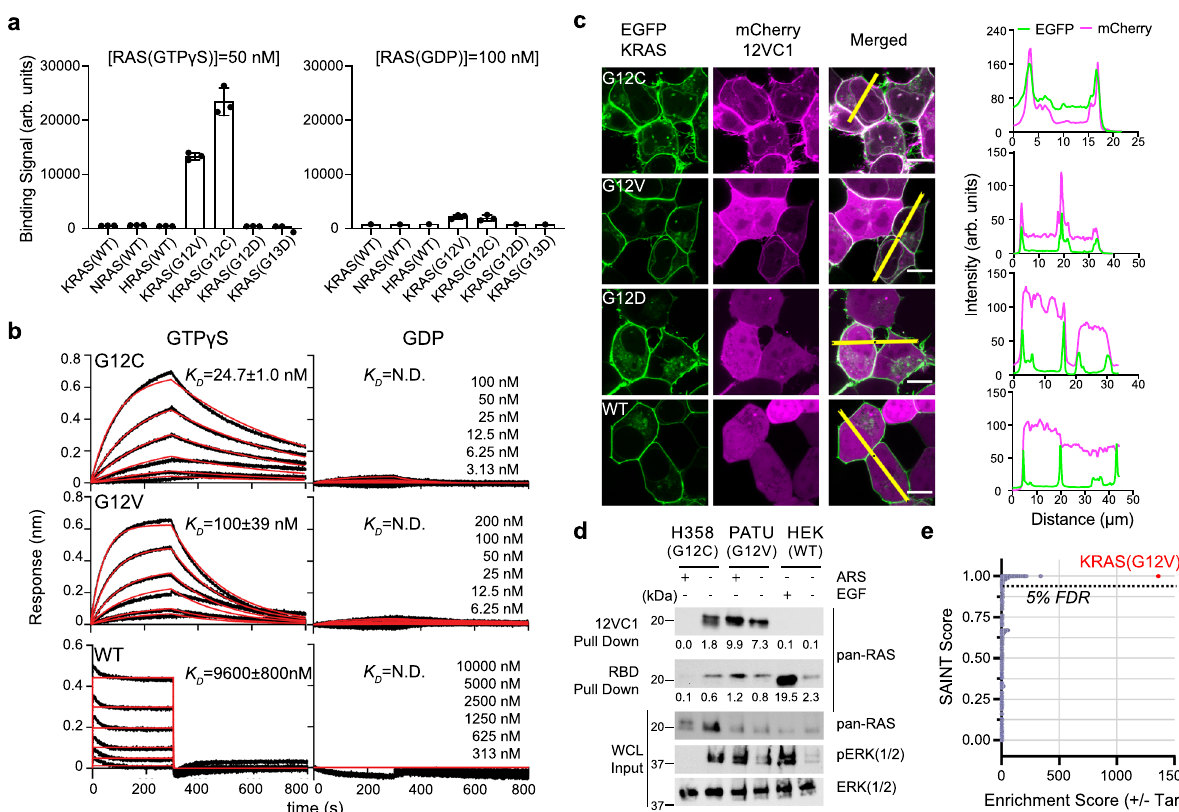
Fig. 1 Monobody 12VC1 is selective to the G12C and G12V RAS mutants. a Yeast display binding measurements of 12VC1 to the wild-type RAS isoforms and KRAS mutants in GTP γ S (50 nM) or GDP (100 nM) bound forms. Each data point represents one technical replicate. Binding of biotinylated RAS was detected with neutravidin-Dylight 650. Binding signals in arbitrary units (arb. units.) are the median fl uorescence intensity of the fl uorescent population in the 75 – 95th percentile of the Dylight 650 detection channel of a fl ow cytometer. The mean and SD of three technical replicates are plotted. b BLI sensorgrams of 12VC1 binding against different KRAS mutants and WT in GTP γ S or GDP-loaded state. The experimental BLI traces (black) for G12C and G12V in the GTP γ S-bound state were globally fi tted (red) using the 1:1 binding kinetic model. Steady-state global analysis was performed for KRAS(WT). The K D values shown are the mean ± SD from n = 3, technical replicates. N.D., not determined due to too weak binding. c Colocalization of mCherry fused 12VC1 (pseudo-color magenta) with overexpressed EGFP fused KRAS(WT) and mutants (pseudo-color green). Scale bar denotes 10 μ m. The graphs on the right show the fl uorescence intensity pro fi les under the yellow lines across the microscopy images. d Pull-down assay with biotinylated 12VC1 and GST- RBD of lysates of cell lines containing KRAS(G12C) and (G12V) and (WT) with and without ARS1620 and EGF treatments. Captured proteins (12VC1 pull down and RBD pull down) were probed using immunoblotting with a pan-RAS antibody. The amounts of RAS, total ERK, and pERK in the input lysate (WCL) were assessed using immunoblotting. Representative data shown (technical replicate, n = 2). e Af fi nity puri fi ed-mass spectrometry (AP-MS) analysis using 12VC1 as a capture reagent. The SAINT score 50 and enrichment score of each protein that was uniquely present in the af fi nity puri fi ed sample of KRAS(G12V) harboring cell line (PATU8902) over non-KRAS mutant cell line (A375) are plotted. The data showed that 12VC1 captured overwhelmingly more KRAS(G12V) from PATU8902 than from A375. The red dot represents SAINT score and enrichment score of KRAS(G12V). The dashed line signi fi es the cutoff for 5% false detection rate